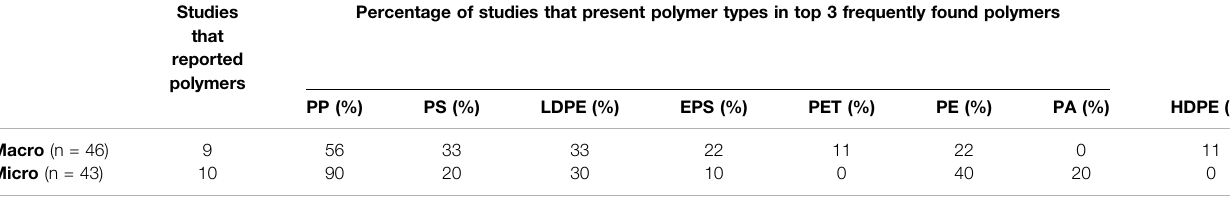
TABLE4| Countofpolymersfoundintopthreemostabundantpolymersperstudy,withabbreviationsforthefollowingpolymertypes:polypropylene(PP),polystyrene(PS), low density polyethylene (LDPE), expanded polystyrene (EPS), polyethylene terephthalate (PET), polyethylene (PE), high density polyethylene (HDPE), and polyamide (also known as nylon,